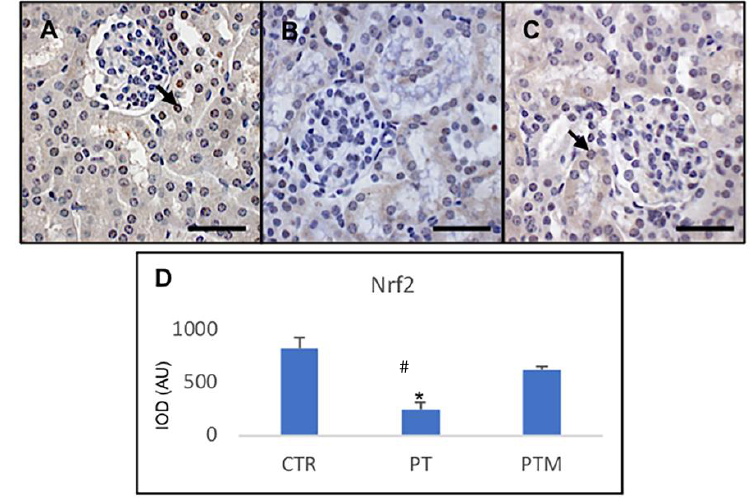
# Figure 4. Photomicrographs showing transforming Nrf2 immunohistochemistry of control mice ( A ), pristane-LN mice ( B ) and pristane-LN mice treated with melatonin ( C ). Bar equals 20 µ m. The graph ( D ) summarizes Nrf2 immunohistomorphometrical analysis of all experimental groups. Arrows indicates nuclear expression of the protein. * # indicate respectively statistically significant di ff erences vs. control and pristane-LN mice treated with melatonin: p < 0.05. CTR: control mice PT: pristane-LN mice PTM: pristane-LN mice treated with